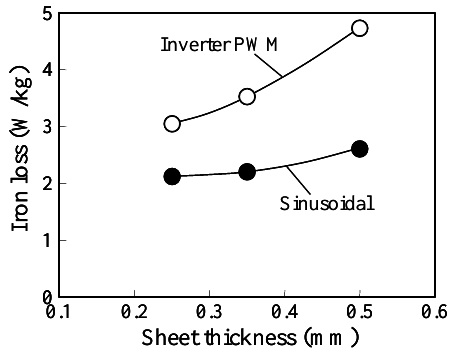
Figure 7. Dependence of iron loss on sheet thickness comparing sinusoidal and inverter excitation. Maximum flux density: 1.5 T, fundamental frequency: 50 Hz, carrier frequency: 1 kHz, modulation index: 0.4.